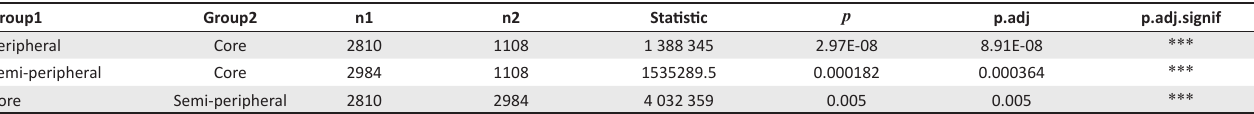
TABLE 3-A1: Test statistics of Mann–Whitney U tests for difference in recruitment rates in the three long-term density zones. p -values corrected for multiple comparison by Holm method. Group1